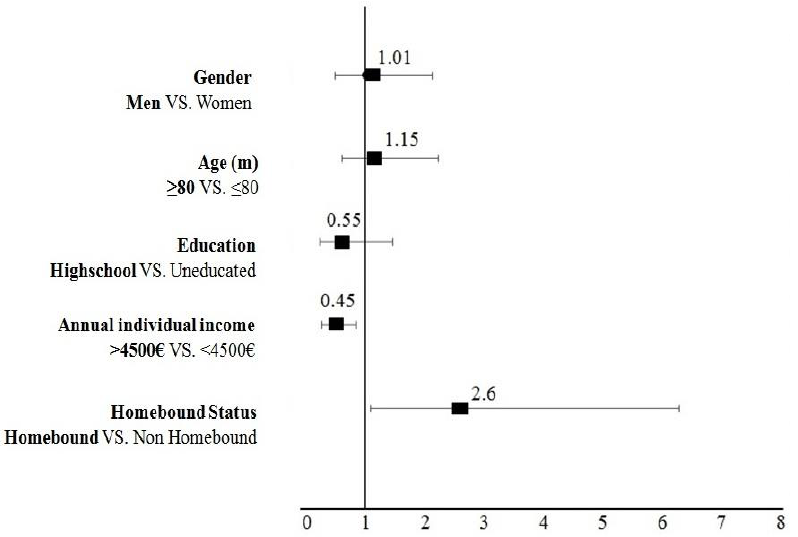
Figure 3. The impact of Socioeconomic factors on Frailty (Multi-variate model analysis). Notes: An OR > 1 indicates a greater likelihood of elders (Men, >80, Highschool, Homebound VS., etc.) to be frail. Bars represent 95% (CI). Adjusting OR for gender, age, annual individual income, smoking, and educational level. Abbreviations: OR, odds ratio.